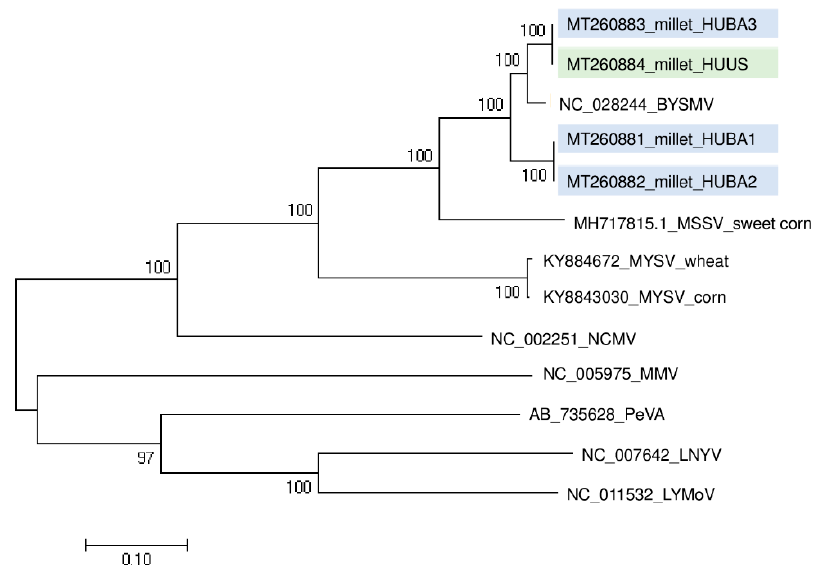
Figure 4. Phylogenetical analysis of the barley yellow striate mosaic virus (BYSMV) strains originated from BA and US. (MSSV—Maize sterile stunt virus, MYSV—Maize yellow striate virus, NCMV—Northern cereal mosaic virus, MMV—Maize mosaic virus, PeVA—Persimmon virus A, LNYV—Lettuce necrotic yellows virus, LYMoV—Lettuce yellow mottle virus).